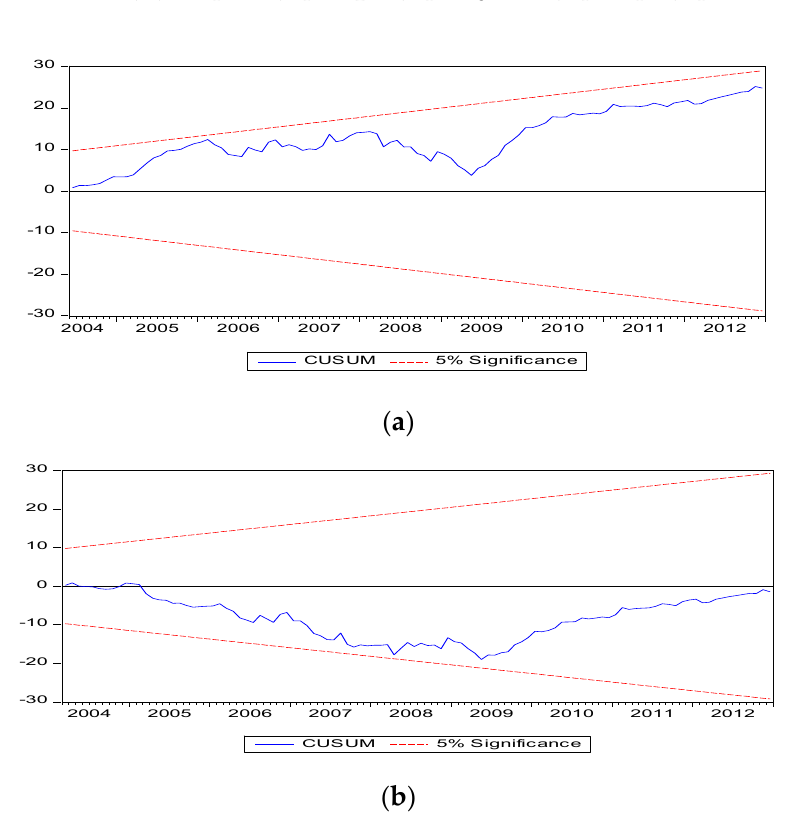
Figure 2. Recursive Estimation CUSUM Test Before and After Error Correction Term.